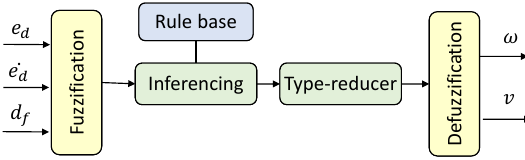
Figure 5. Architecture of the Interval Type 2 Fuzzy Logic System (IT2-FLS).